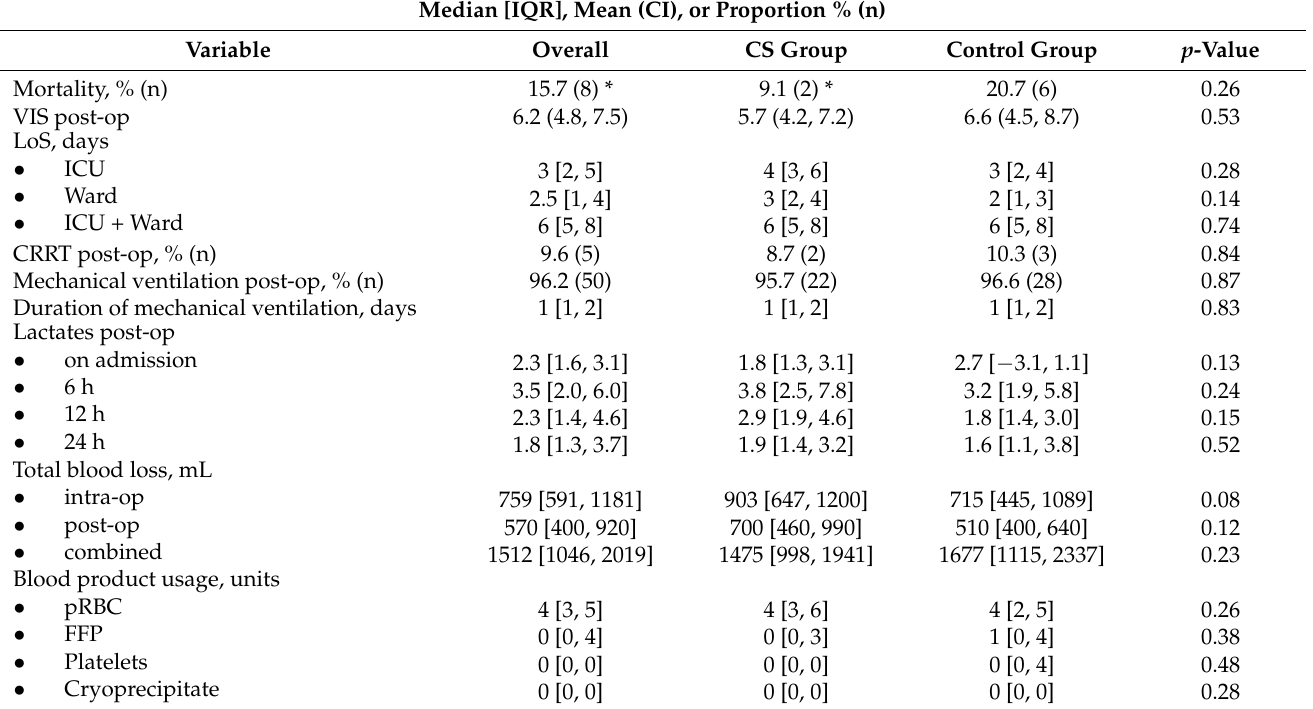
Table 3. Secondary outcomes.